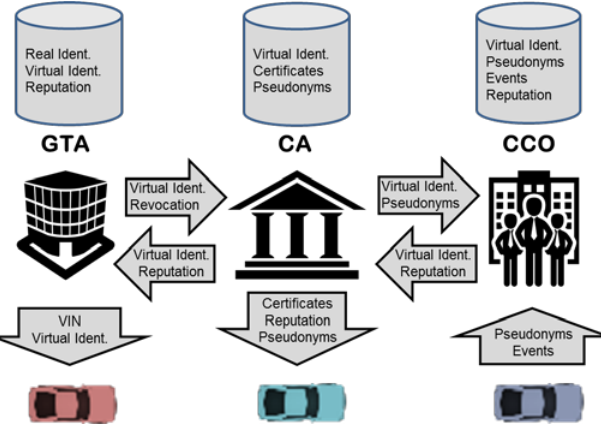
Figure 2. Relationships between entities in the system.